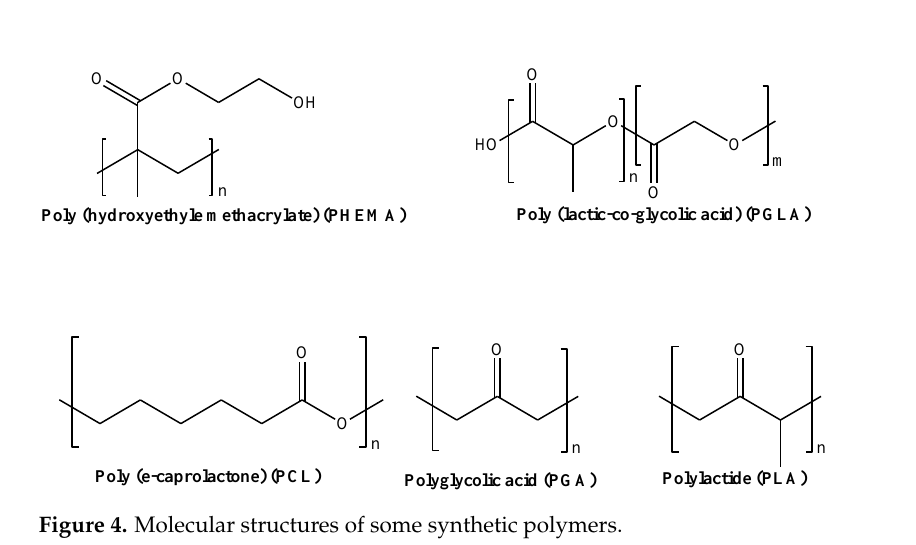
Figure 5 below. Hydrogel materials are normally categorized into three groups: in situ forming hydrogels, acellular hydrogels, and hydrogels with integrated sensors.